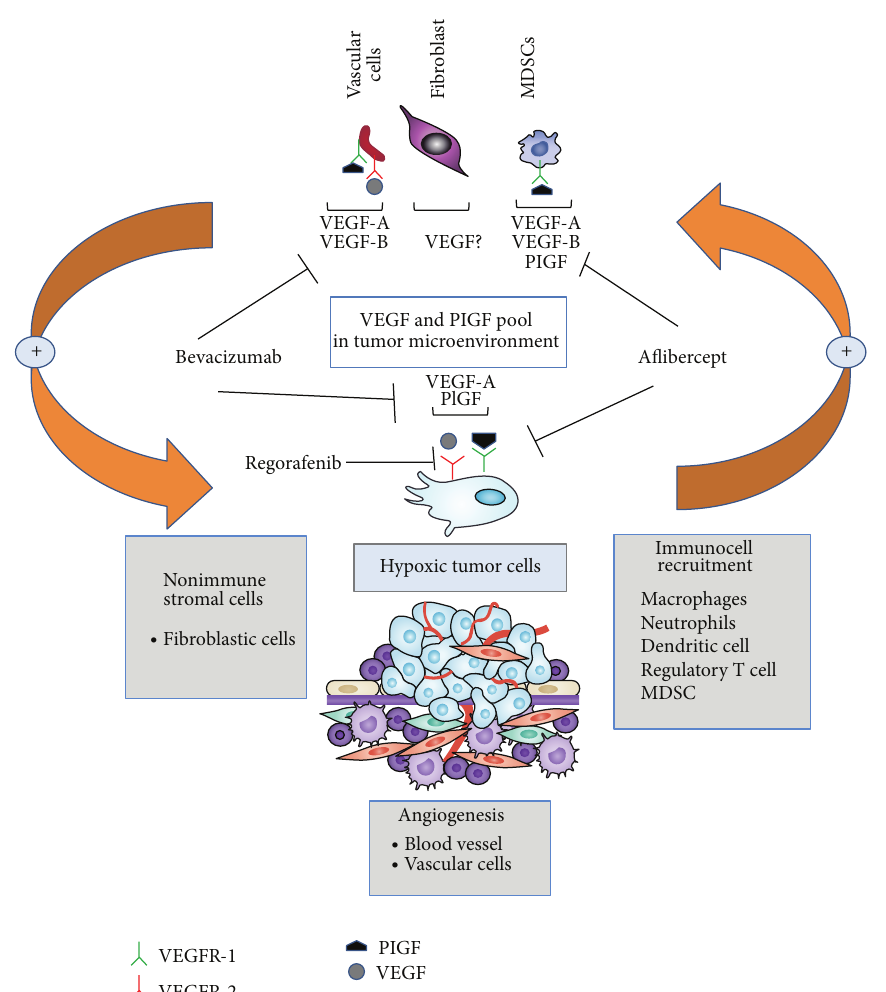
Figure 2: New molecules targeting angiogenesis and crosstalks between angiogenesis and tumor microenvironment. Simplified and schematic view of how multiple cells contribute to the VEGF and PlGF pool in the tumor microenvironment. The tumor microenvironment (TME)consistsofsolublemolecules,immune,nonimmunefibroblastic,vascular,andmalignantcellsthatinteractinaparacrineandautocrine fashion to promote cancer growth and metastasis. Hypoxia is the most potent stimulus for inducing the main angiogenic factors, VEGF and PlGF. Myeloid derived suppressor cells (MDSCs) might confer resistance to therapies that target VEGF by secreting additional proangiogenic factors and specifically by expressing VEGFR-1 (also known as FLT1). PlGF signals directly through VEGFR-1 in various cell types, including endothelial cells, angiogenesis-competent myeloid progenitors, macrophages, and tumour cells and thereby promotes tumour growth and the formation of the premetastatic niche. A substantial fraction of tumours is resistant or escapes antiangiogenic inhibitors that target VEGF-A signalling (bevacizumab) through therapy-induced injury, metabolic changes, inflammation, and possibly expansion of MDSCs. Differently from other antiangiogenic drugs, aflibercept targeting PlGF should reduce the source of the compensatory upregulation of angiogenic factors by inhibiting immune cells recruitment and/or polarization and the release of angiogenic factors by tumour and vascular cells. Regorafenib is a multikinase inhibitor against selected tyrosine kinases and signal transduction VEGFR2-3/RAF/MEK/ERK